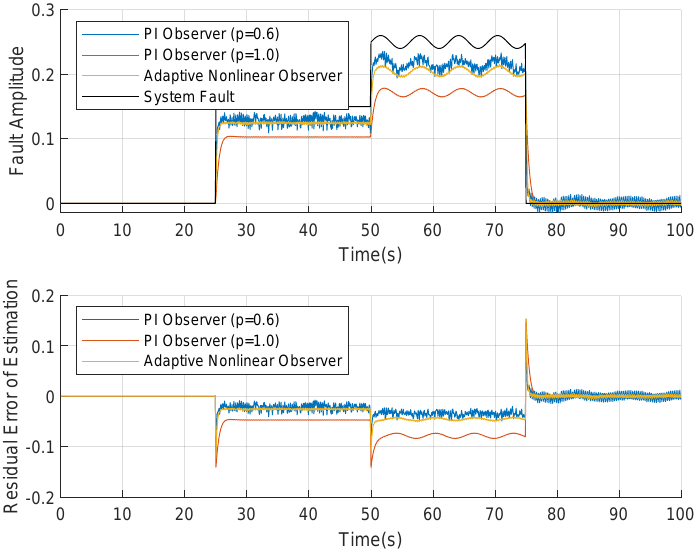
Figure 5. Fault estimation of nonlinear observer with adaptive parameters (without noise). When Gaussian noise with mean value of 0 and variance of 0.05 is added to the system state, the system fault can still be effectively estimated, and the result is shown in Figure 6. Further, Figure 6 shows that the fault diagnosis algorithm based on adaptive nonlinear PI observer can still achieve better fault estimation effect in the case of system error. error is significantly reduced, and the fault estimation result is more robust than that of the fault diagnosis algorithm based on nonlinear PI observer with fixed